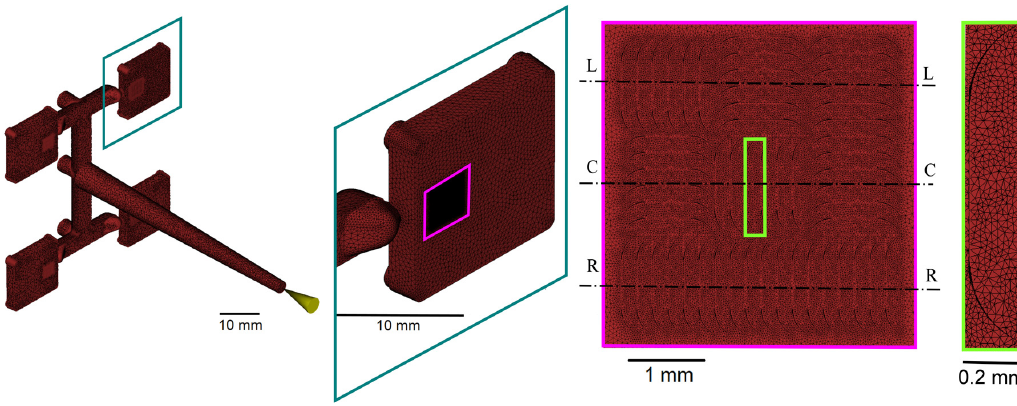
Figure 13. The multi-scale mesh of the optical demonstrator with selected surface features included in the geometry [35].